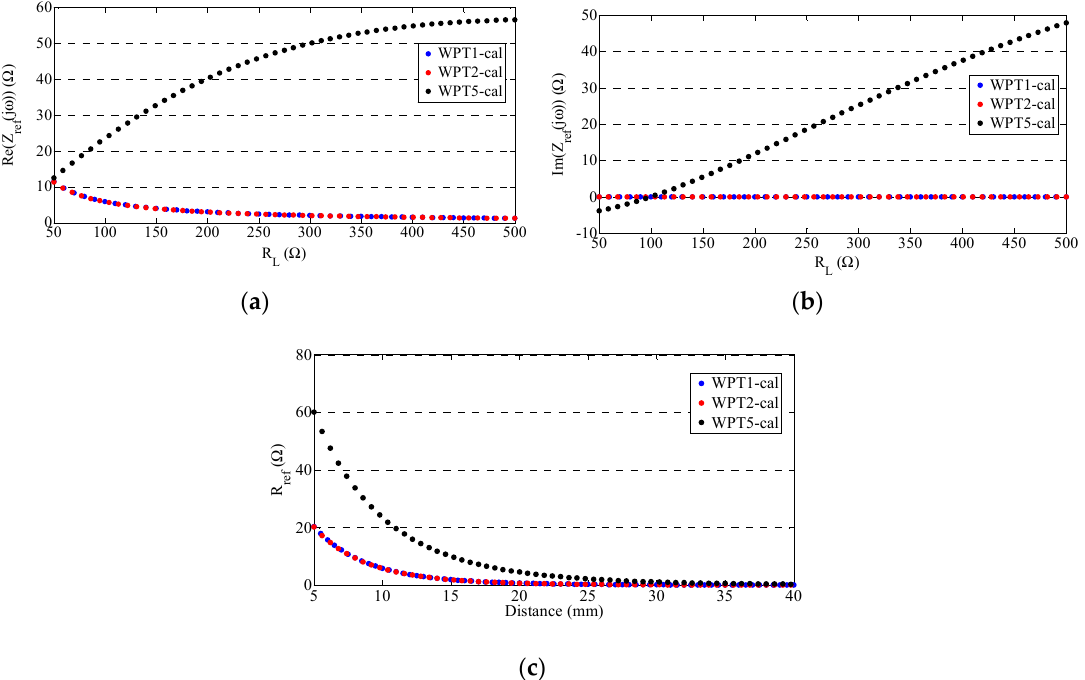
Figure 5. Effect of load resistance ( a ), ( b ) and coils relative distance ( c ) on the reflected impedance. The term “-cal” refers to the calculation results.